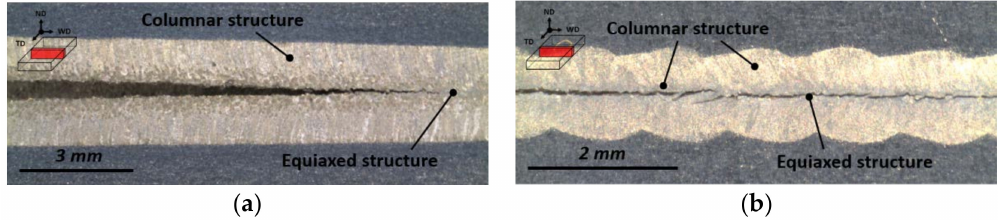
Figure 8. Bead appearance view from the normal direction depending on the welding condition ( a ). Circular scanning pattern with 900 W laser power and 1.6 mm oscillation width at 3 m/min welding speed and 100 Hz oscillation frequency and ( b ) infinite-shaped scanning pattern 900 W laser power and 0.4 mm oscillation width at 100 Hz and 3.5 m/min welding